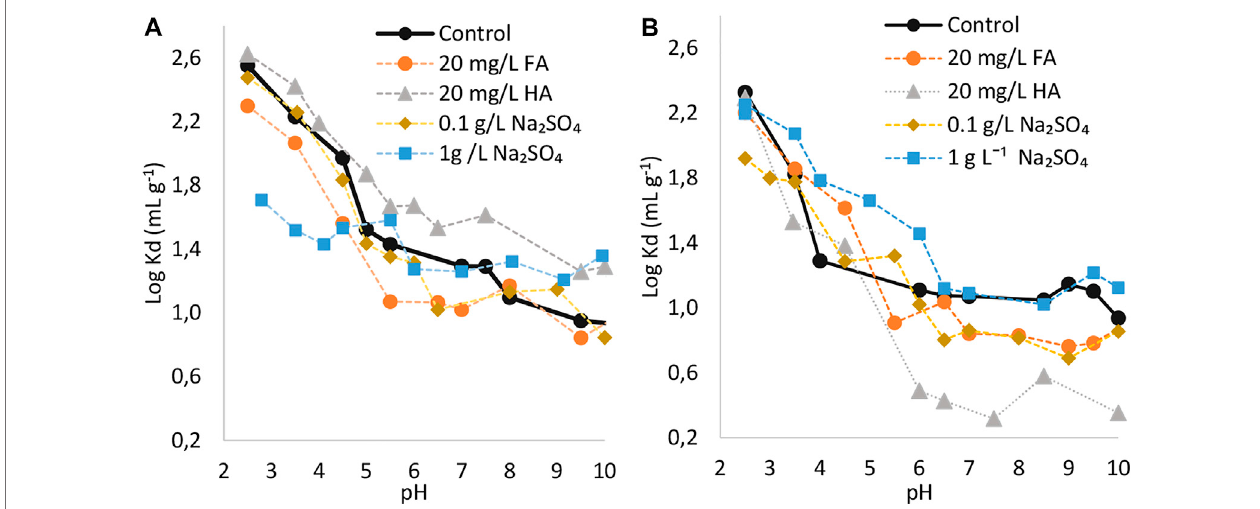
FIGURE3| Logarithmicsorptioncoef fi cientsofL-PFOSon (A) topsoil(1)and (B) subsoil(1)asafunctionofpHandeffectofdissolvedhumicsubstancesorsodium sulfate.